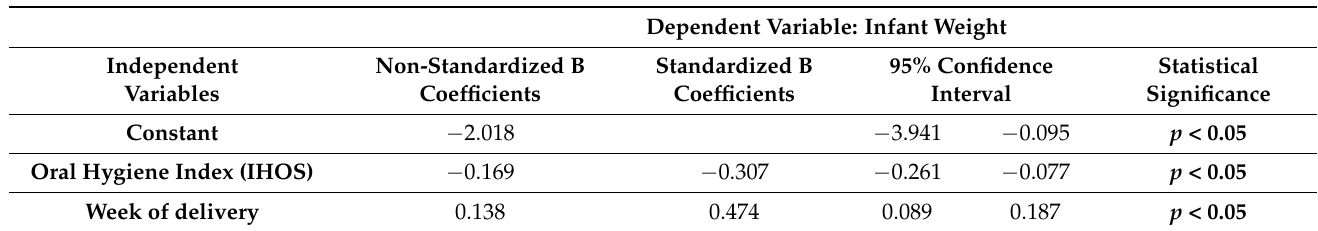
Table 5. Multiple linear regression models.